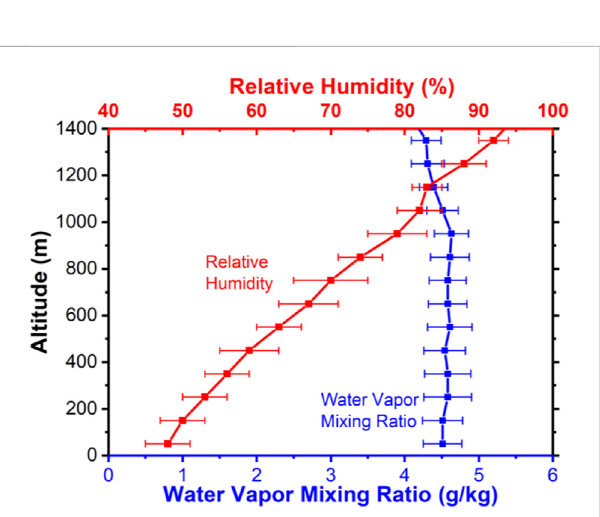
FIGURE 4 Average pro fi lesof water vapor mixing ratio andrelativehumidity derived from the four dropsondes deployed during the fl ights